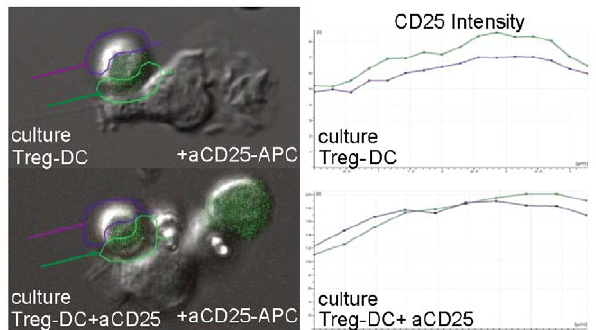
Figure 1. CD25 localizes to Treg:dendritic cell contact site. Foxp3-GFP Treg cells from C.CgFoxp3tm2Tch/J mice were co-cultured with BALB/cJ splenic DCs and anti-CD3 with or without unlabeled anti- CD25 antibody. Live cell confocal imaging was performed on Treg:DC conjugates 24 h later as in materials and methods. Anti-CD25-APC was added to the cultures prior to collecting imaging data. Left : DIC/GFP/ APC projection images of Treg:DC conjugate from culture without blocking, unlabeled anti-CD25 (upper) and culture with blocking, unlabeled anti-CD25 (lower). Right: The corresponding LCS-Lite analysis of the relative intensity of anti-CD25-APC (y-axis) on Treg membrane not contacting (purple) or in contact with (green) the DC across multiple z-stacks (x-axis).